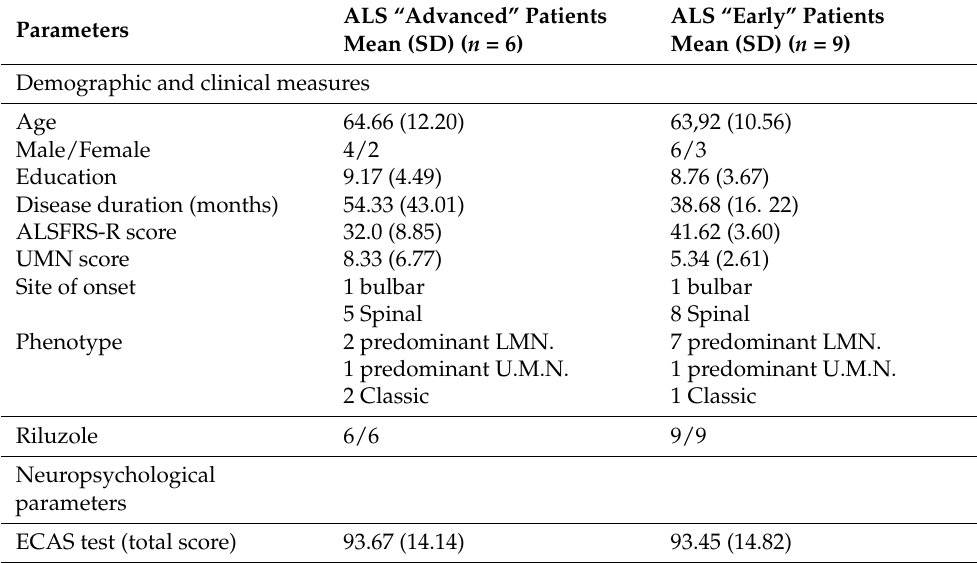
Table 1. Demographics and clinical information of the